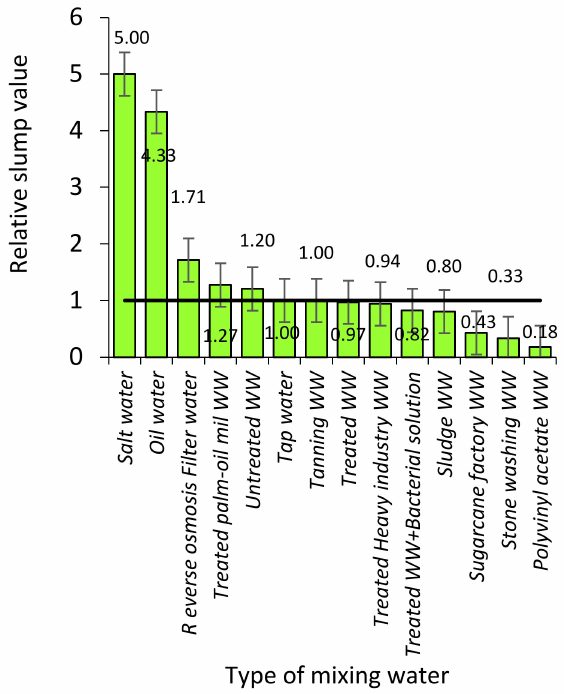
Figure 2. Effect of different types of WW on the slump of